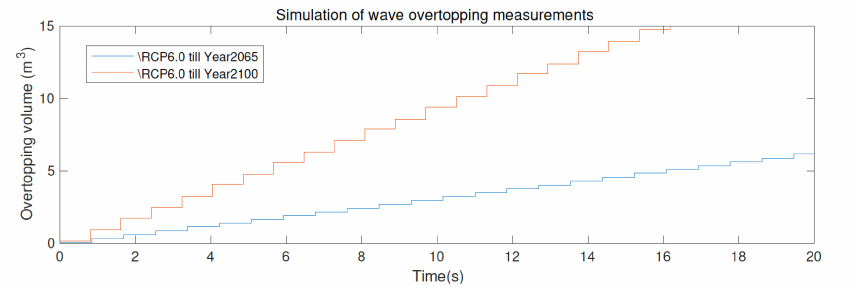
Figure 12. Overtopping volume over the double-dike defence structure under the RCP4.5 scenario.